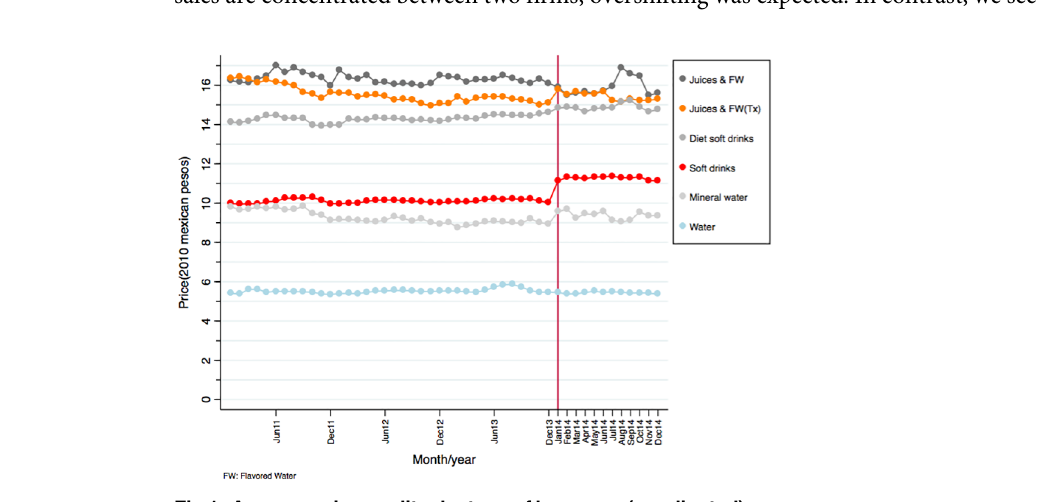
Fig 1. Average price per liter by type of beverage